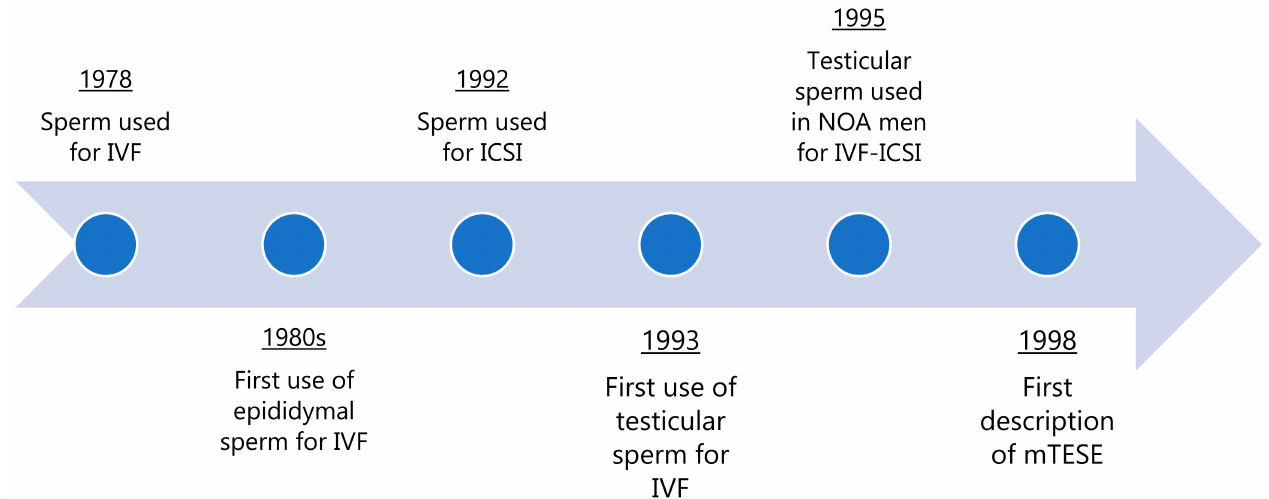
Figure 1. Timeline of the history of surgical sperm retrieval prior to the discovery of mTESE. IVF: in vitro fertilization; ICSI: intracytoplasmic sperm injection; NOA: non-obstructive azoospermia; mTESE: microdissection testicular sperm